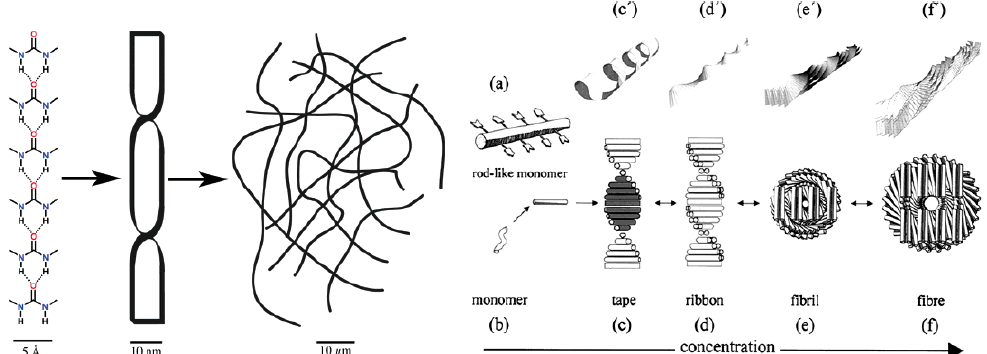
Figure 7. Structure of a supramolecular gel. Different structural levels are shown. Reprinted with permission from [92]. Copyright 2004 American Chemical Society.